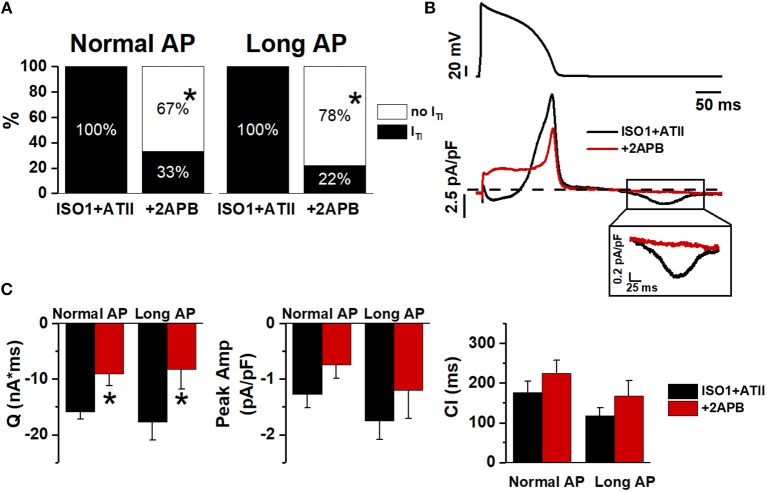
Effect of 2APB on ITI induced by ISO+ATII. (A) ITI incidence in ISO1+ATII alone and with 2APB. (B) Examples of Normal AP (top) and Im corresponding (bottom). (C) statistic (mean ± S.E.) of ITI charge (Q); peak ITI amplitude (Peak Amp) and coupling interval (CI). N = 9 for both groups. *p > 0.05 vs. ISO1+ATII.